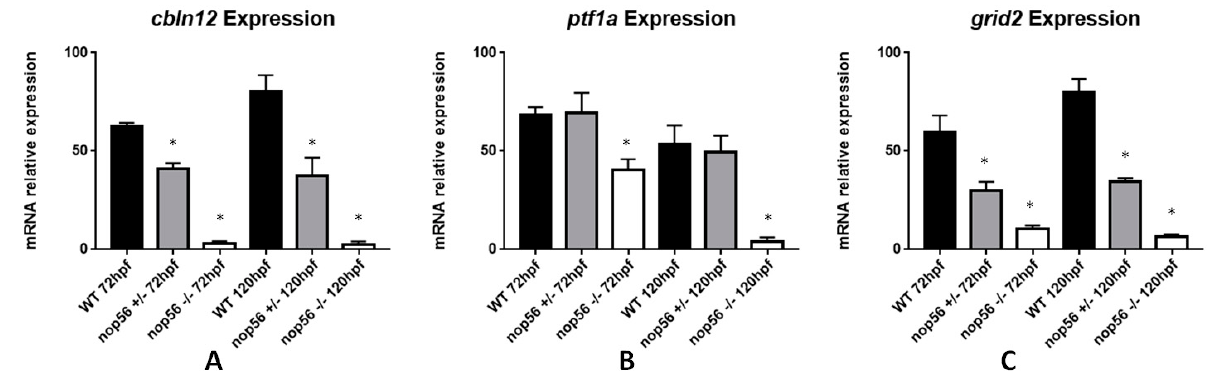
Figure 3. Graphic representation of expression analysis by RT-qPCR. ( A ) Cbln12 expression is significantly reduced in nop56 +/ − and nop56 − / − embryos between at 72 and 120 hpf in comparison with wild-type embryos ( p -value < 0.0001). ( B ) Ptf1a expression is significantly reduced in nop56 − / − embryos at 72 and 120 hpf ( p -value < 0.0001.) ( C ) Grid2 expression is significantly reduced in nop56 +/ − and nop56 − / − embryos between at 72 and 120 hpf in comparison with wild-type embryos ( p -value < 0.0001). Statistically significant data in the graphs is indicated with a *.